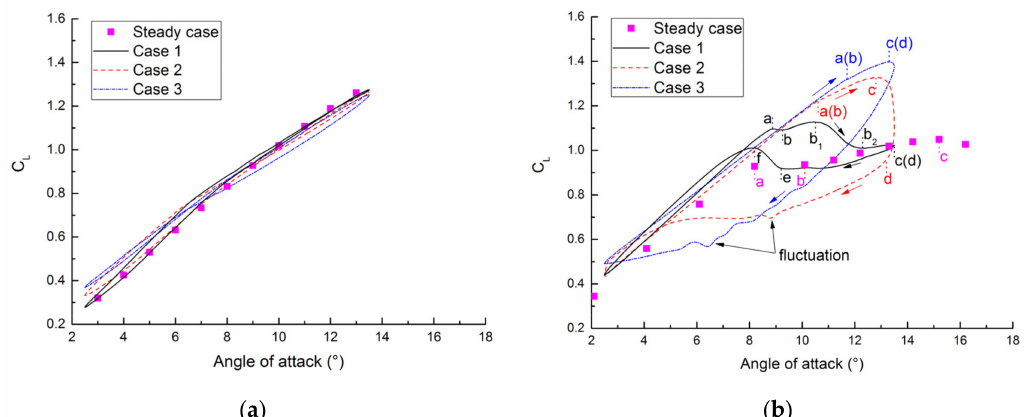
Figure 4. Lift coefficient hysteresis loops of two airfoils in four cases in a clean air flow: ( a ) NACA0012 airfoil; ( b ) S809 airfoil.